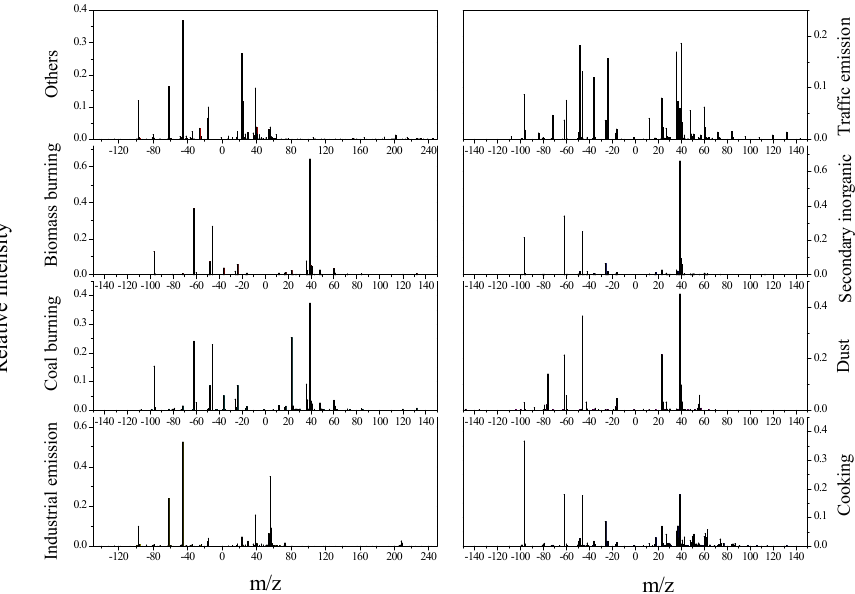
Figure 3. The average mass spectral profiles for eight pollution source types.